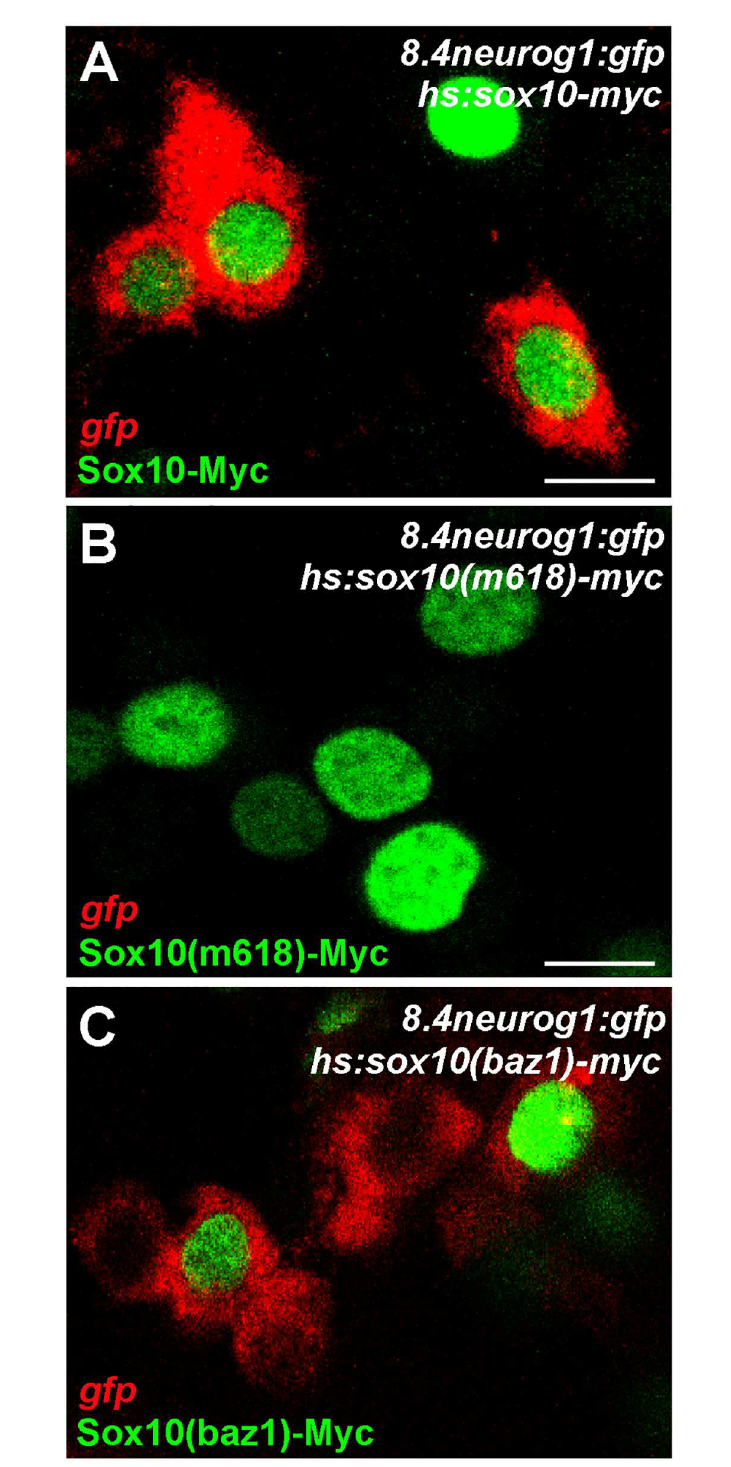
Fig 8. Sox10(baz1) retains transcriptional activity at neurog1. Tg(8 . 4neurog1 : GFP) embryos were injectedwith expressionplasmidsencodingvariants of Sox10. Embryos were heat-shocked at 7 hpf and fixed at 10 hpf. Expression of the Sox10 variant proteins was detected by immunofluorescentdetectionof their Myc tags (green) and activation of the neurog1 reporter gene is seen by In situ hybridisation againstthe gfp mRNA (red). Note how both WT and baz1 proteins activate Tg(8 . 4neurog1 : GFP) reporter expression(A C),